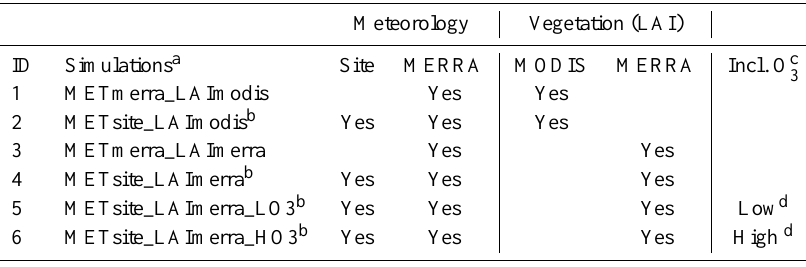
Table 2. Description of the site-level simulations.